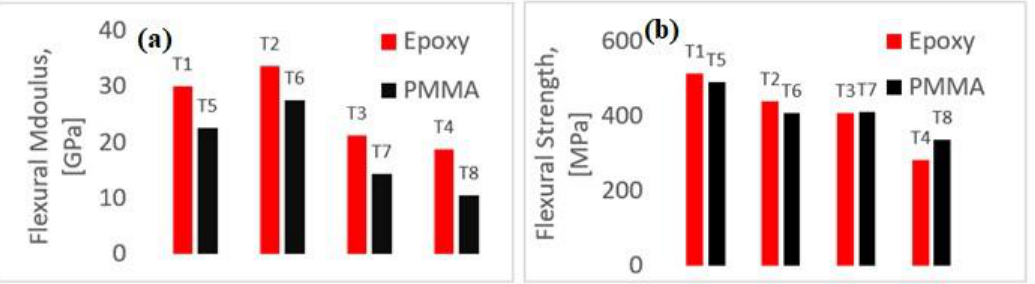
Figure 4. Flexural modulus and strength of pure glass, hybrids, and samples with waviness. ( a ) Flexural modulus comparisons from T-1 to T-8 and ( b ) Flexural strength comparison from T-1 to T-8